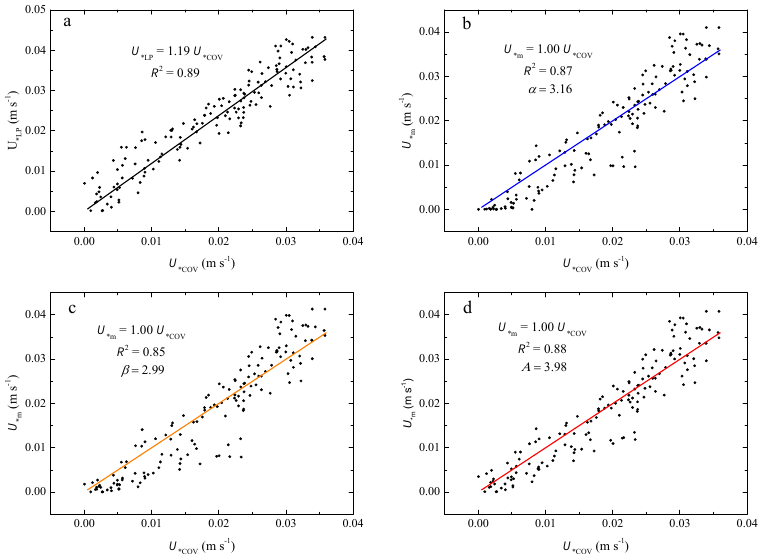
Figure 7. Linear regressions between ( a ) U * estimated from the LP method ( U *LP ) and that from the COV method ( U *COV ); ( b ) the modified friction velocity ( U *m ) based on Fischer et al. (1979) and U *COV ; ( c ) U *m based on Smith and McLean (1977) and U *COV ; and ( d ) U *m based on Adams and Weatherly (1981) and U *COV . The values of the empirical constants α , β , and A are written in ( b – d ), respectively.